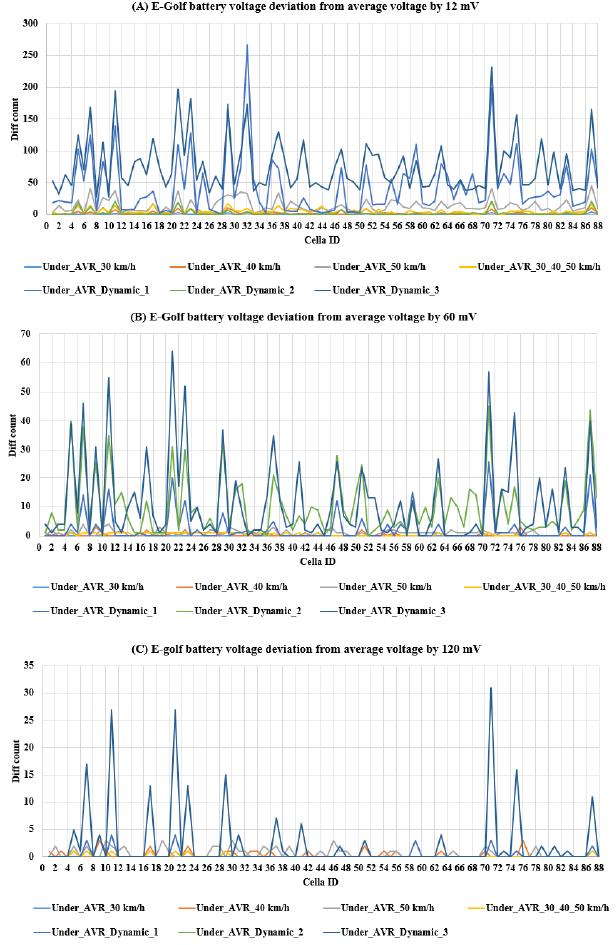
Figure 12. Number of deviations from the average voltage of 12 mV/60 mV/120 mV. The deviation from 12 mV in part (a), from 60 mV in part (b), and from 120 mV in part (c) have been analyzed (see Figure 12). It can be seen that as the deviation limit is increased, the number of deviations from the average voltage is continuously reduced. When analyzing 60 mV, it can be seen that there is almost no deviation at constant loads. The best range for analyzing very critical/large deviations is 120 mV (measurement range 10%), which may also indicate a possible battery cell error. Even then, there is a